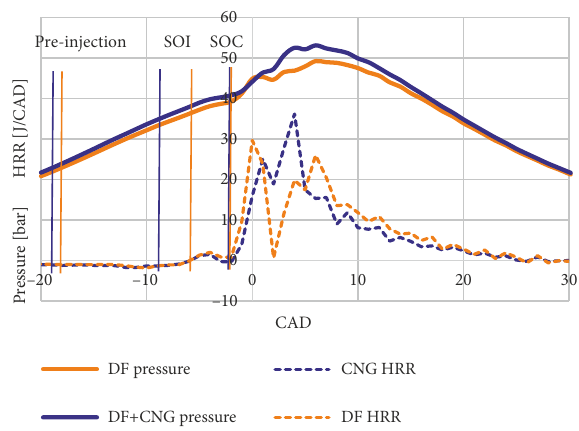
Figure 4. Combustion pressure and HRR at a 10% load